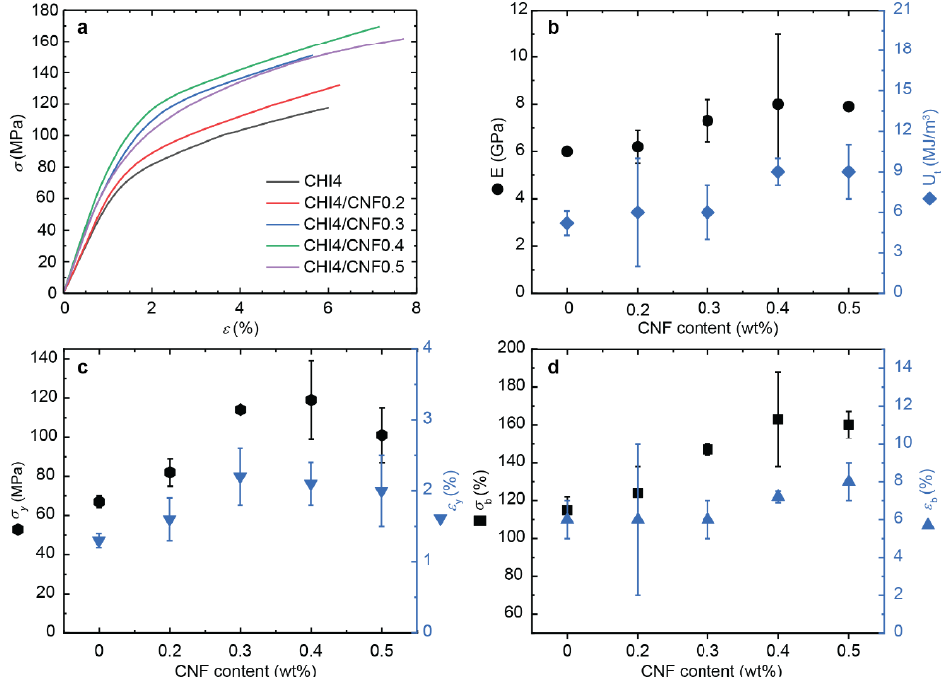
Figure 10. Tensile mechanical properties of spun CHI/CNF fibers obtained for different formulations. ( a ) Nominal stress – strain curves. Evolution of ( b ) Young’s modulus E and toughness U t , ( c ) the stress ( σ y ) and strain ( ε y ) values at the yield point, ( d ) the stress ( σ b ) and strain-at-break ( ε b ), with the increase of CNF content.